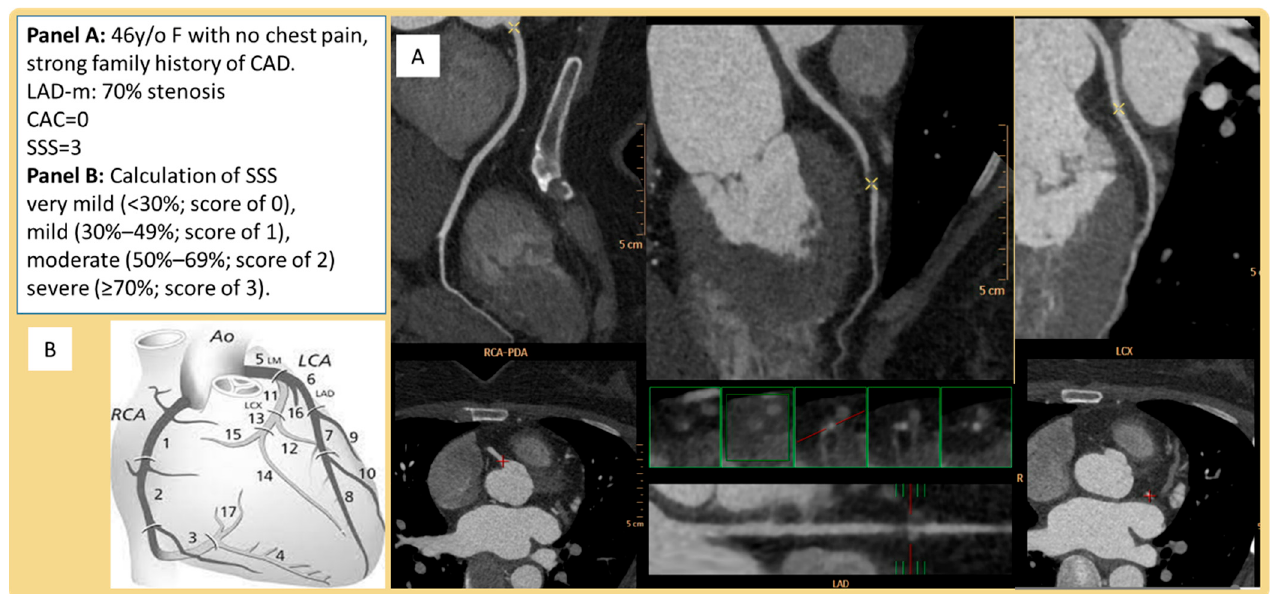
Figure 1. Example of SSS calculation. CAD = coronary artery disease, LAD = left anterior descending artery, SSS = segment stenosis scores.